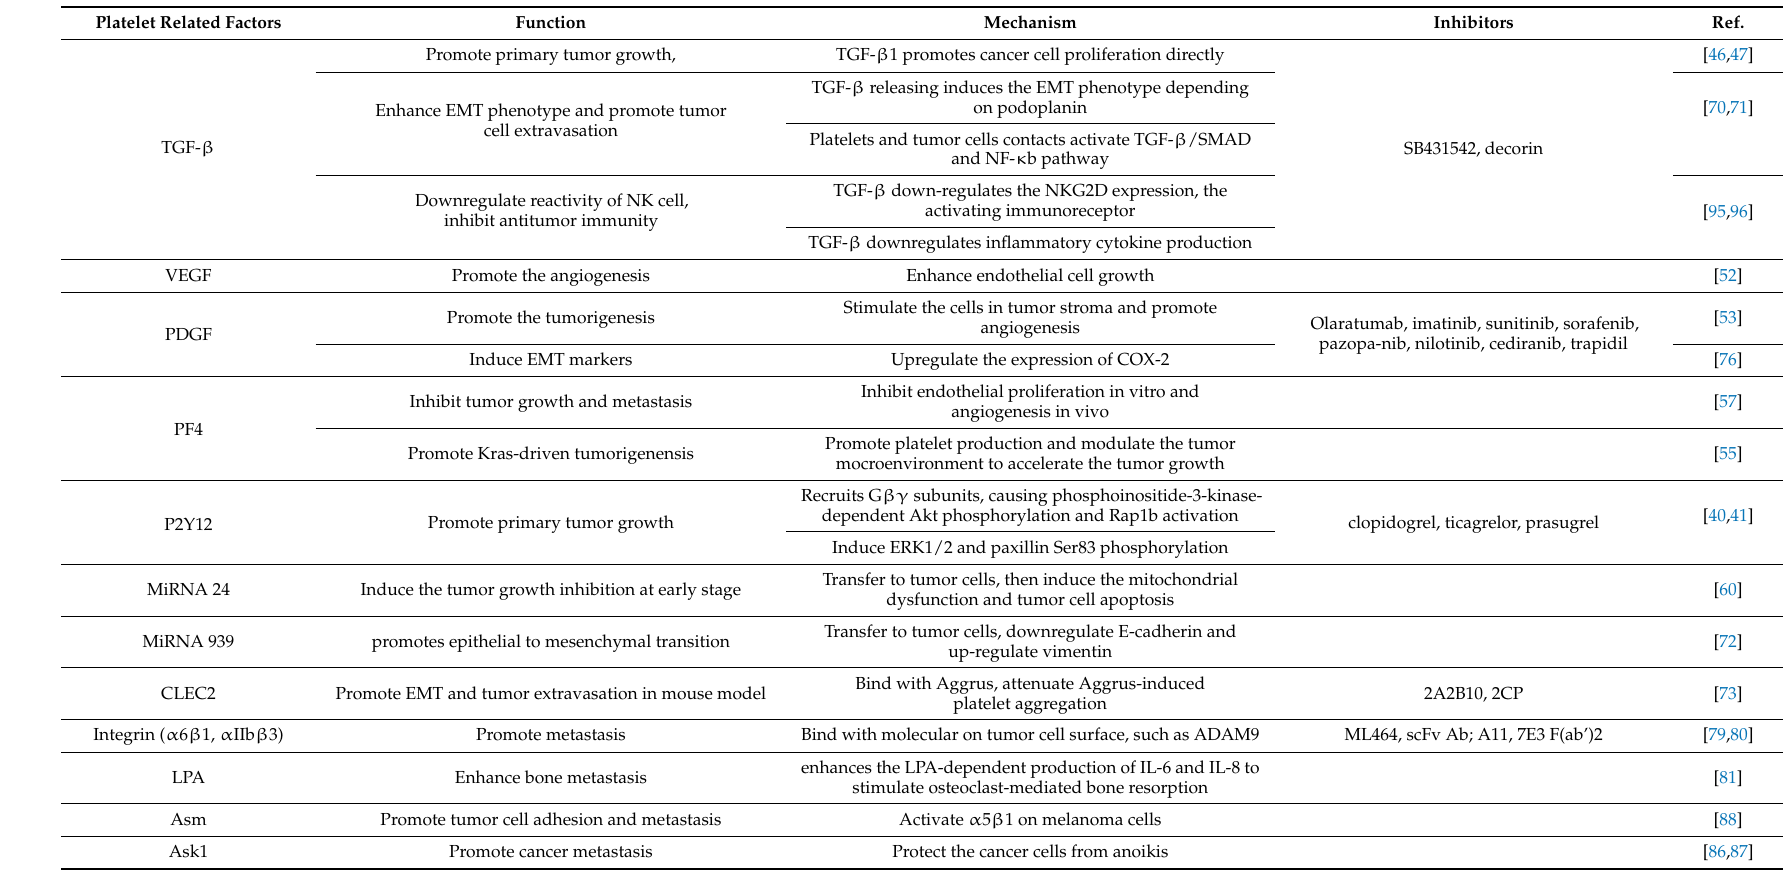
Table 1. Function of platelet–derived factors and proteins in cancer development and